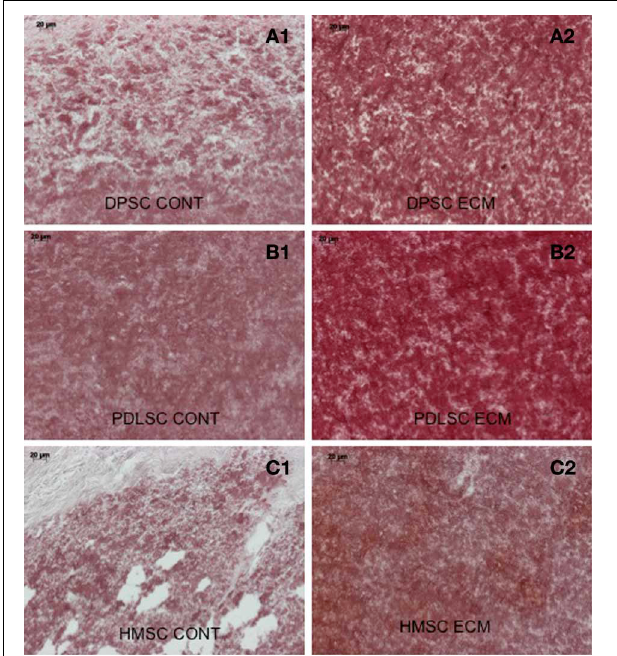
FIGURE 8 | Alizarin red staining. The micrographs are representative images of explant sections containing DPSCs (A) , PDLSCs (B) , and HMSCs (C) in control collagen/chitosan scaffolds (A1–C1) and pulp ECM scaffolds (A2–C2) . Note the increased calcium deposition when the three cell types are cultured within the pulp ECM scaffolds (comparing A1 , B1 , and C1 with A2 , B2 , and C2 respectively). The scale bar in all the images represents 20 μ m.